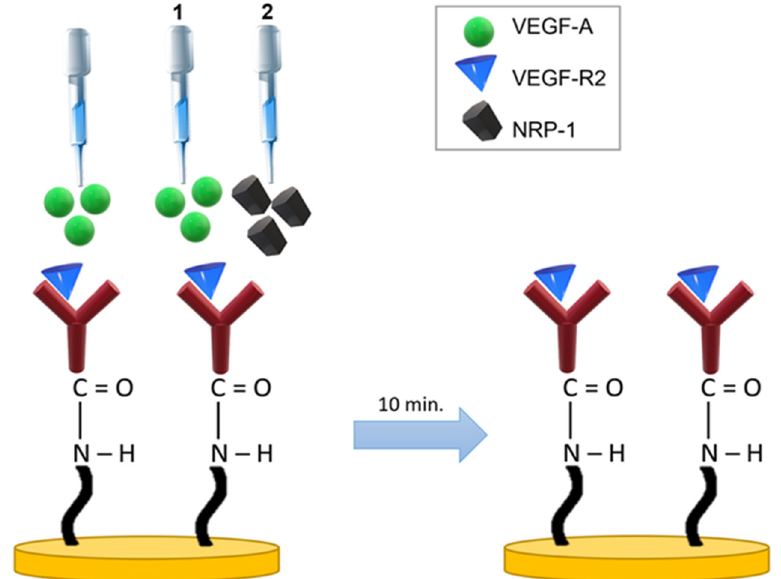
Figure A3. Schematic diagram of testing of potential reactions of interferents with ligand-bound VEGF-R2. Ligand concentration was 20 ng/mL, pH = 7.40.